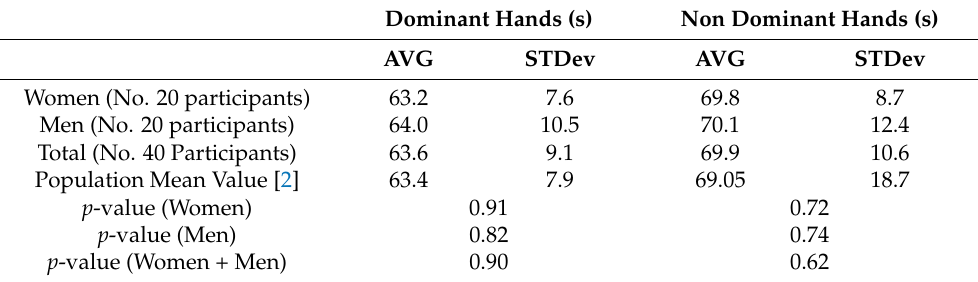
Table 2. The AVG and STDev of measurements of time on Normal Participants aged 20–29 years old. Dominant Hands (s) Non Dominant Hands (s) AVG STDev AVG STDev Women (No. 20